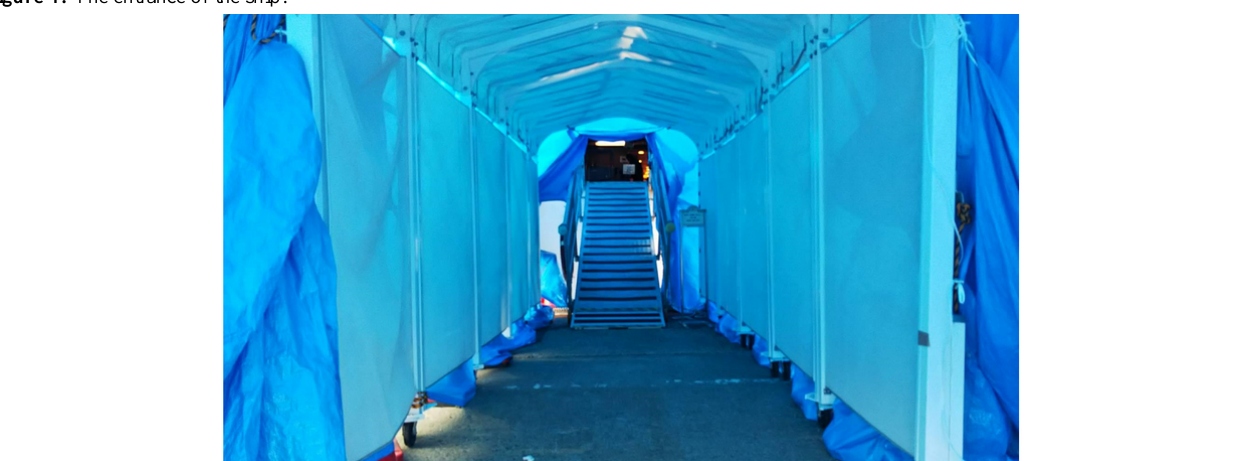
Figure 4. The entrance of the